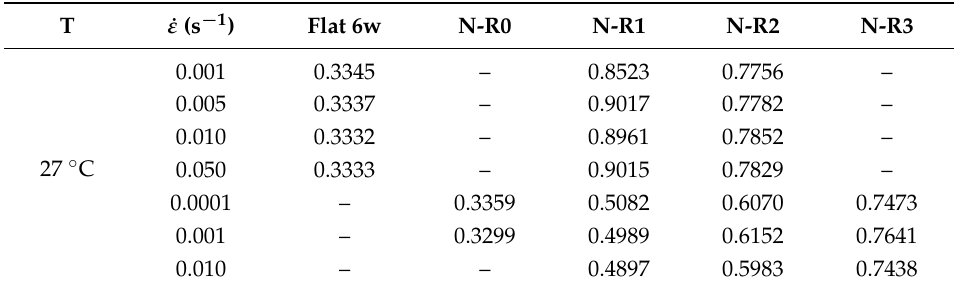
Table 3. Different stress triaxiality data determined from numerical simulations using experimental data from round bar, flat un-notched and pre-notched